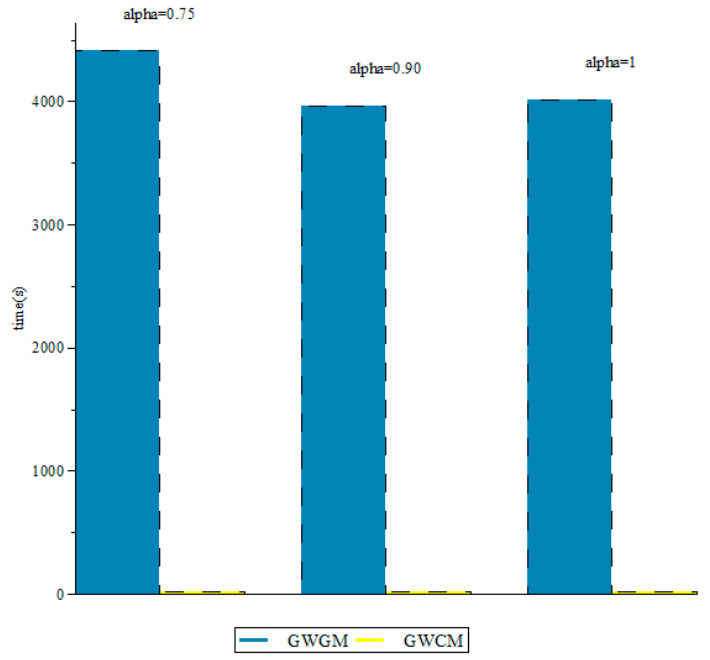
Figure 4. Computation times of Maple codes written for the Gegenbauer wavelets Galerkin method